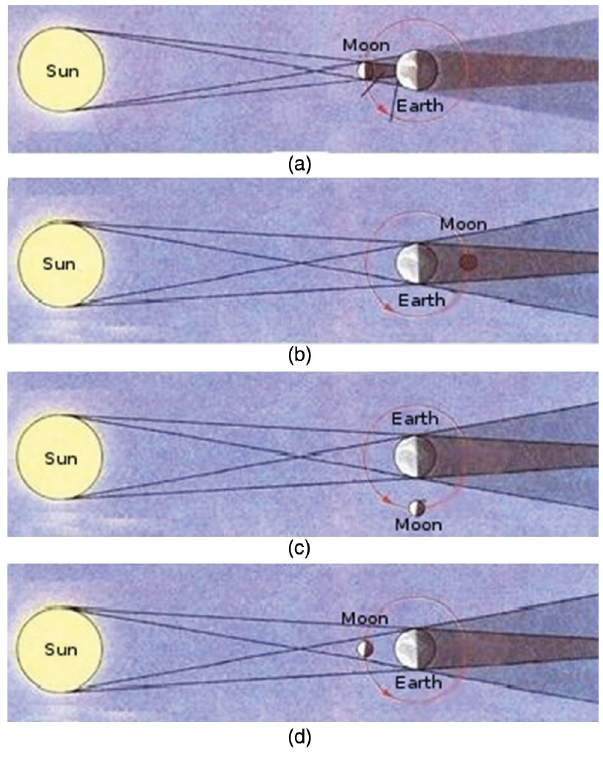
FIG. 15. Solar and lunar eclipses —